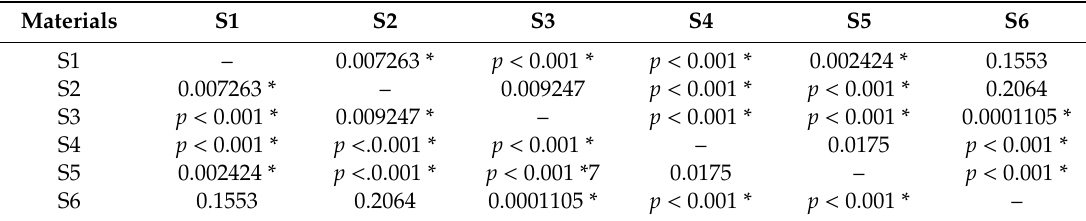
Table 7. Di ff erences in ∆ E after 168 h immersion in orange juice.